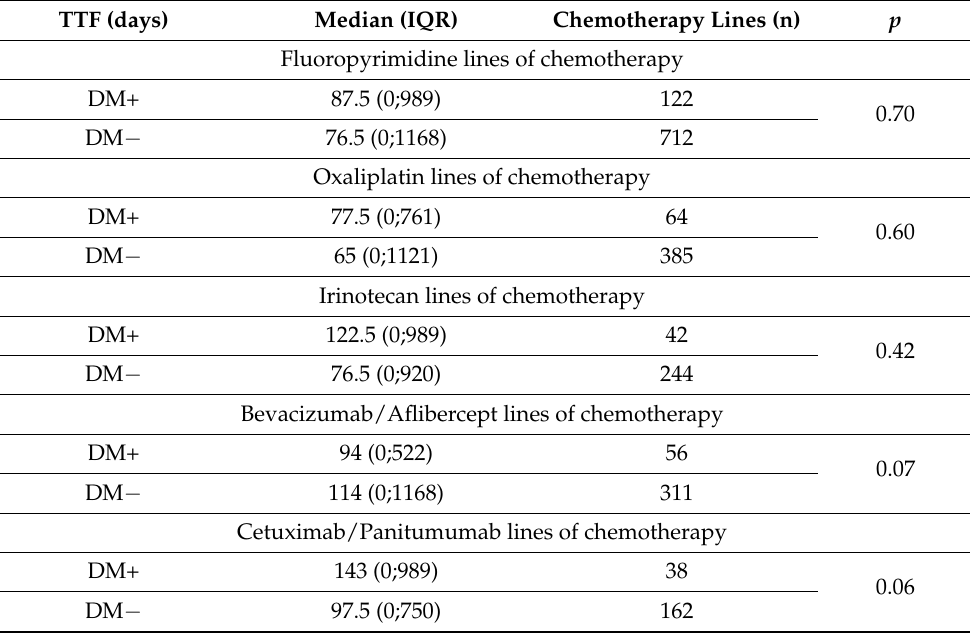
Table 3. Average TTF by DM presence in fluoropyrimidine, oxaliplatin, or irinotecan lines of